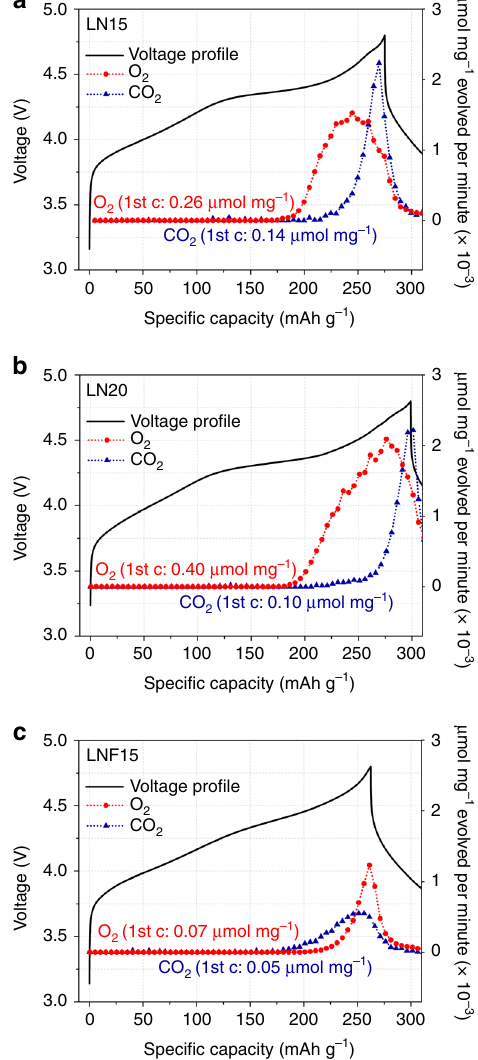
Fig. 6 Differential electrochemical mass spectrometry (DEMS) study of Li 1.15 Ni 0.375 Ti 0.375 Mo 0.1 O 2 (LN15), Li 1.2 Ni 0.333 Ti 0.333 Mo 0.133 O 2 (LN20), and Li 1.15 Ni 0.45 Ti 0.3 Mo 0.1 O 1.85 F 0.15 (LNF15). Voltage pro fi les (black solid) of a LN15, b LN20, and c LNF15 when charged to 4.8 V and discharged to 1.5 V at 20 mA g – 1 , along with the DEMS results on O 2 (red circle) and CO 2 (blue triangle)